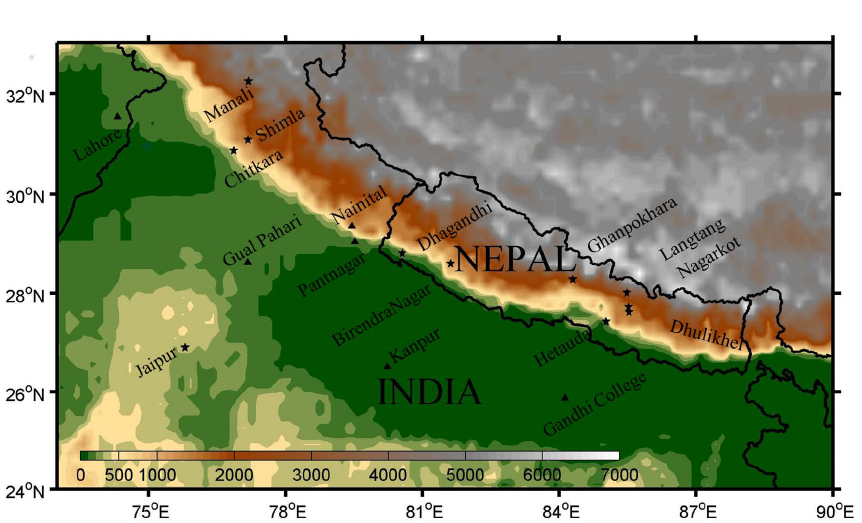
Fig. 1. Major sites of RAJO-MEGHA (stars) with AERONET sunphotometer (triangles) deployments during April-May-June 2009 over northern India and Nepal. Background shading represents elevation in ma.s.l.